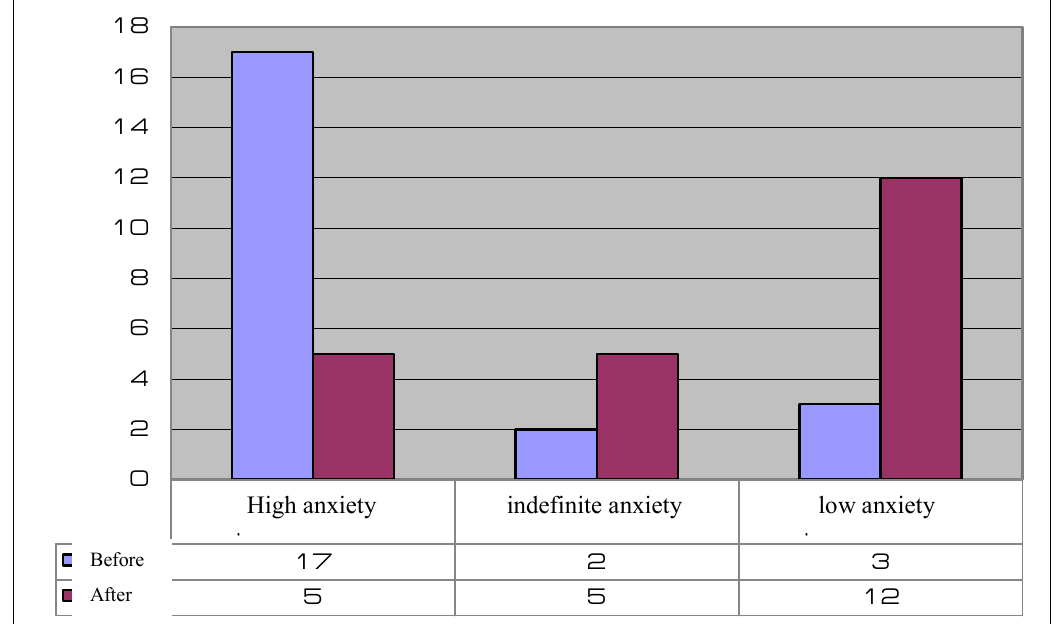
Fig.3. Results of comparative analysis of respondents anxiety levels before and after rehabilitation That is why sportsman cannot always fully emotionally and mentally reconsider and “re-experience”